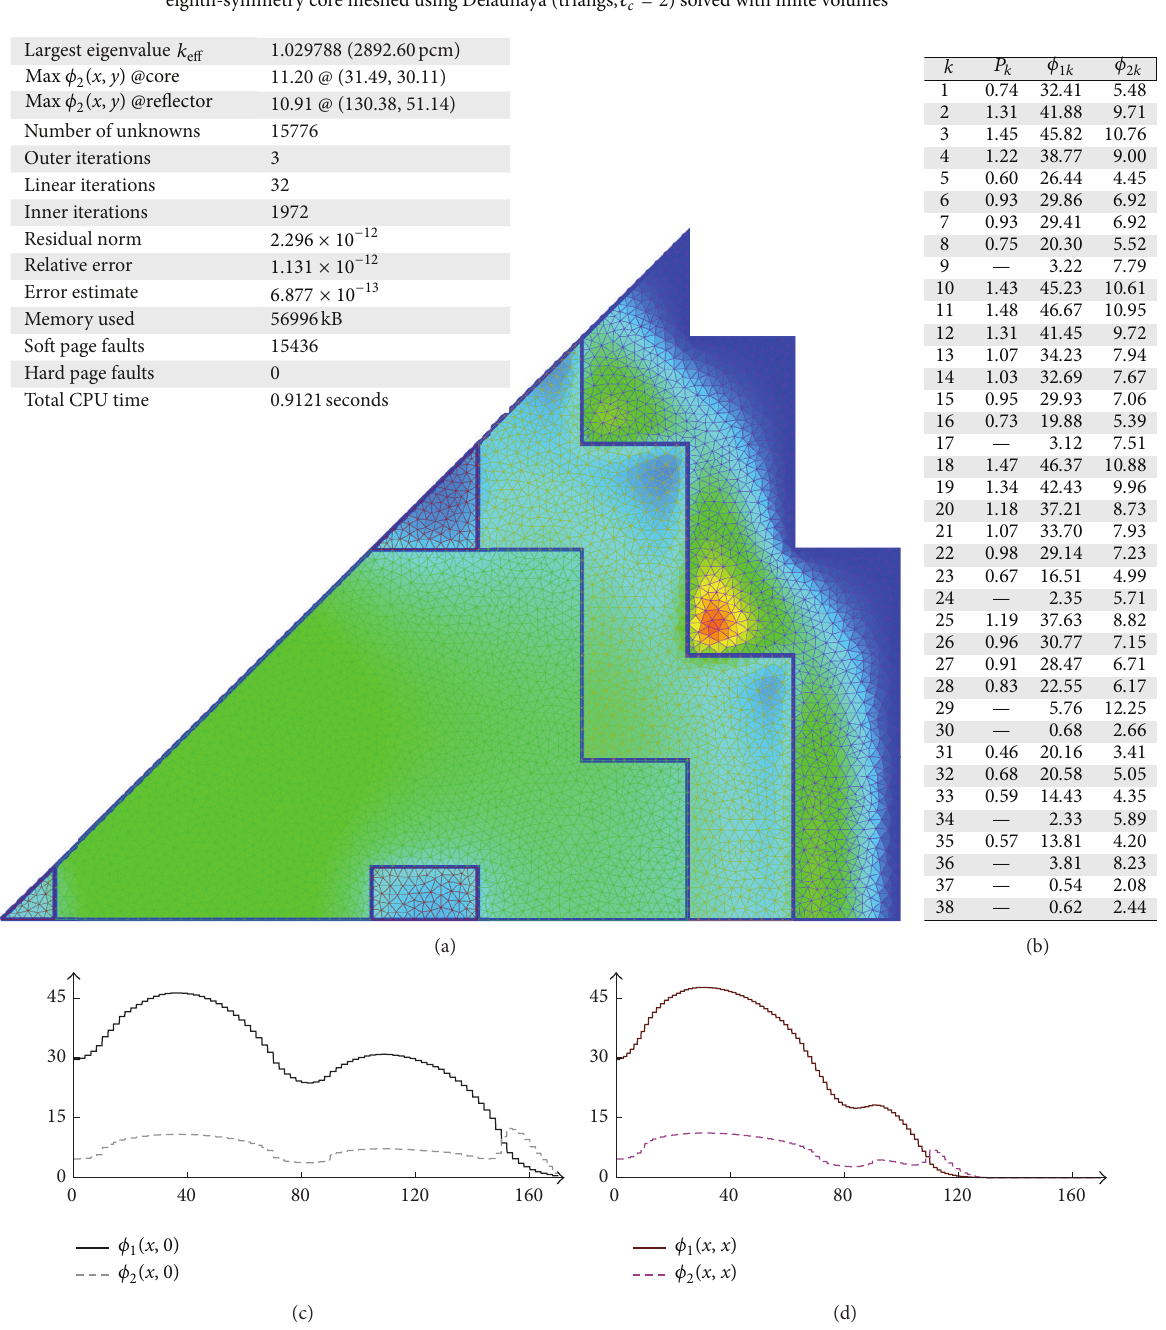
Figure 14: (a) Mesh and thermal flux distribution. (b) Power and fluxes. (c) Flux distribution 𝜙 𝑔 (𝑥,0) along the 𝑥 -axis. (d) Flux distribution (𝑥,𝑥) along the 𝜙 𝑔